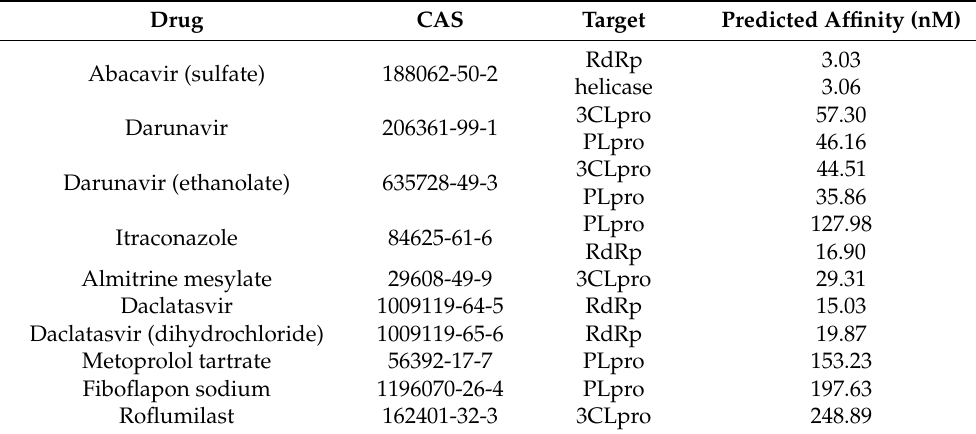
Table 1. Potential inhibitors for SARS-CoV-2.